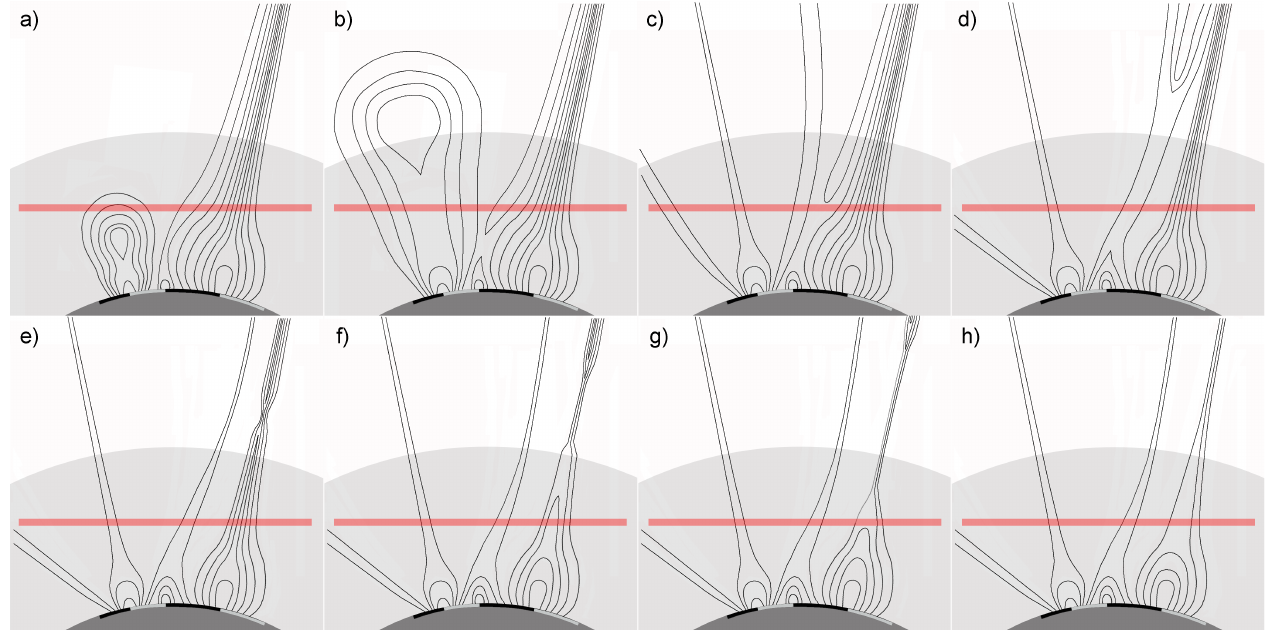
Fig. 4. A cartoon showing the interaction between the expanding CME and the southwest streamer: positive and negative polarities are shown as light and dark gray areas respectively; shaded regions represent coronal altitudes located below the LASCO/C2 occulter (gray) and in the UVCS field of view (red); dimensions are not to scale. As the CME expands (panel a ) magnetic reconnection is induced between the CME flank and the streamer (panel b ); this reconnection proceeds towards higher levels leading finally to the secondary eruption (panels c and d ). The propagation of the eruption close to the streamer axis leads to the streamer pinching by magnetic reconnection along the streamer current sheet (panel e ) and to the subsequent formation of the two Y-shaped features (panel f ) and the final release of a streamer detachment (panels g and h ).